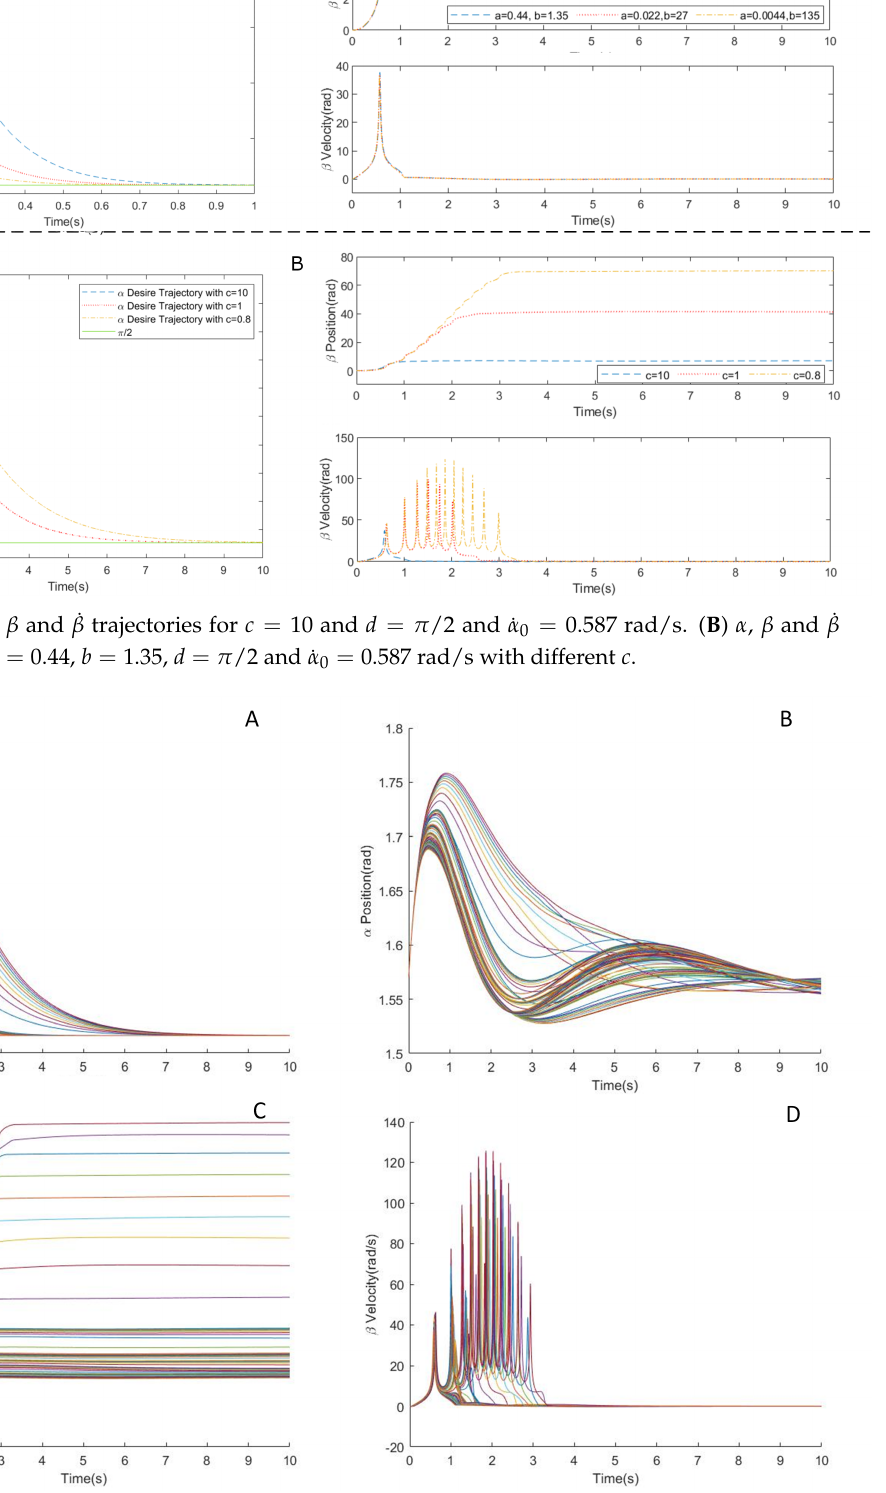
Figure 9. ( A ) Desired trajectory of α . ( B ) Expected trajectory of α obtained from inverse dynamic model. ( C , D ) Expected trajectory of β and ˙ β obtained from inverse dynamic